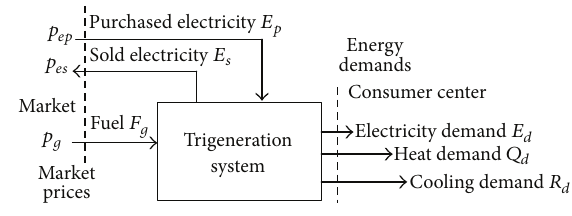
Figure 1: Trigeneration